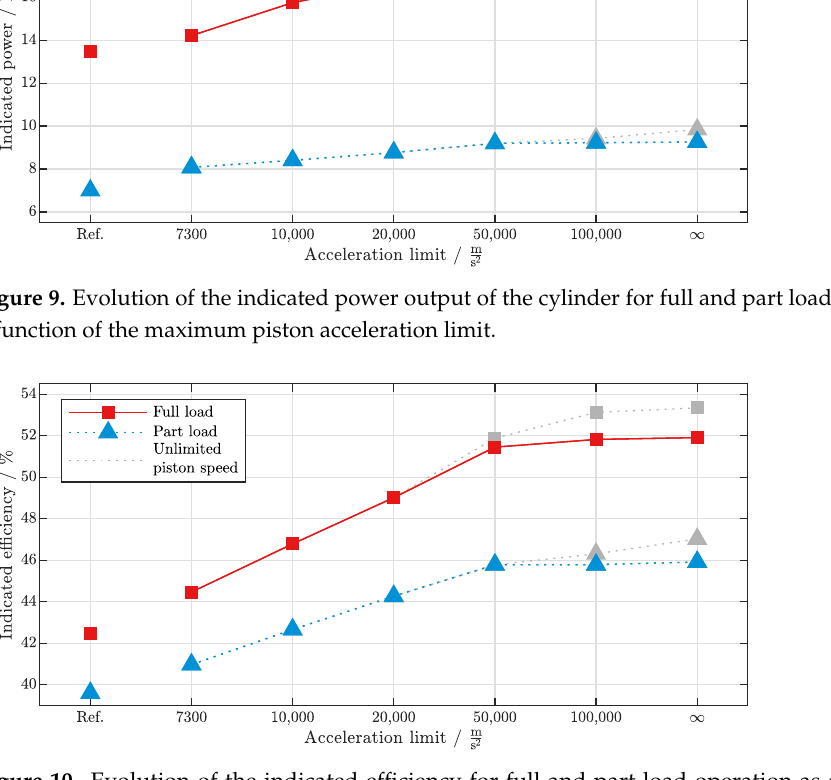
Figure 10. Evolution of the indicated efficiency for full and part load operation as a function of maximum piston acceleration